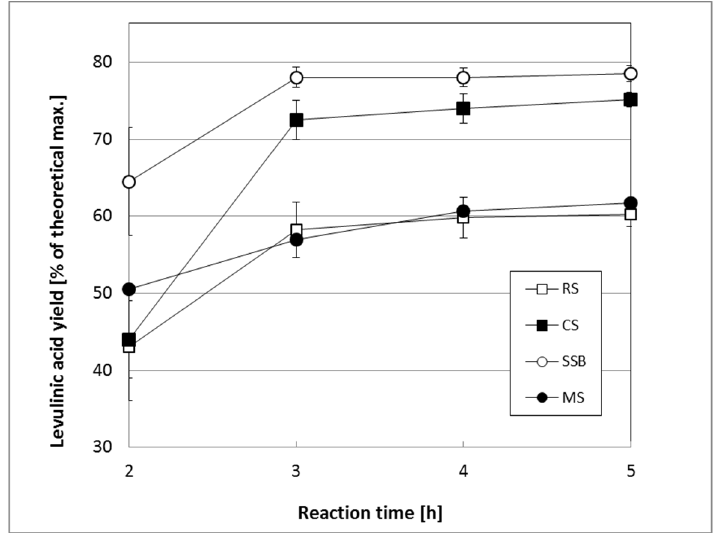
Figure 3. Effect of reaction time on LA production using untreated RS, CS, SSB and MS. Note . Particle size >2000 µm; reaction conditions: 1 M HCl, 150 °C, 50 g/L solid loading.